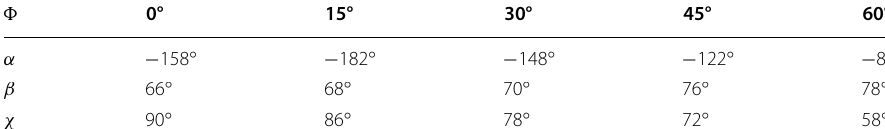
Table 1 Parameters for C UCA,1 maximizing the average correlation in the SCM UMa environment